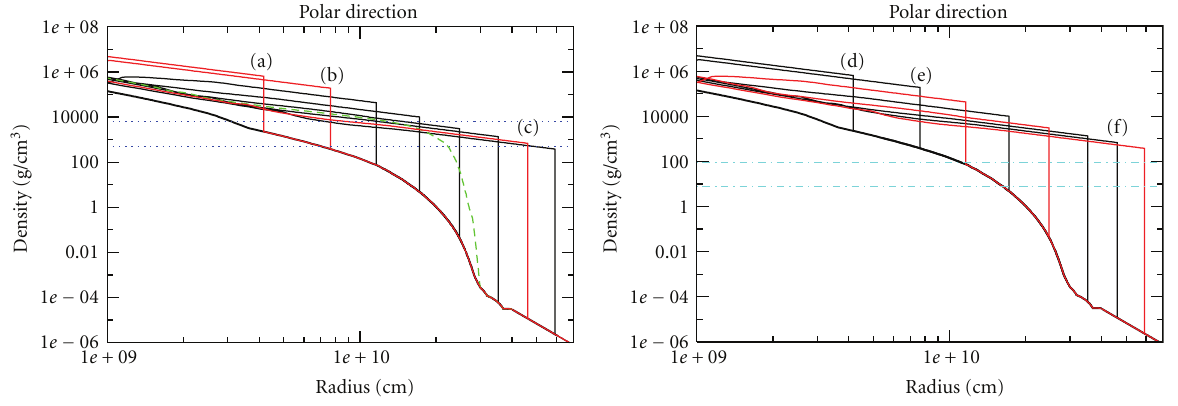
Figure 26: The density profile in the polar direction every 0.4 s as a function of radius. (a), (b) and (c) correspond to 0.4, 0.8 and 2.8 s, respectively. The horizontal blue lines show approximately density of the H-resonance for di ff erent neutrino energies which are 5 (above) and 60MeV (below), respectively. The green line is an original density profile for 2.0 s. Same as the left panel, but for 1.2 s (d), 2.0 s (e), and 3.2 s (f), respectively. Note that a sharpness of the shock along the polar direction is modified from the one in the MHD simulations (green line showing an original density profile for 2.0 s), which is made to be inevitably blunt due to the employed numerical scheme using an artificial viscosity to capture shocks (taken from